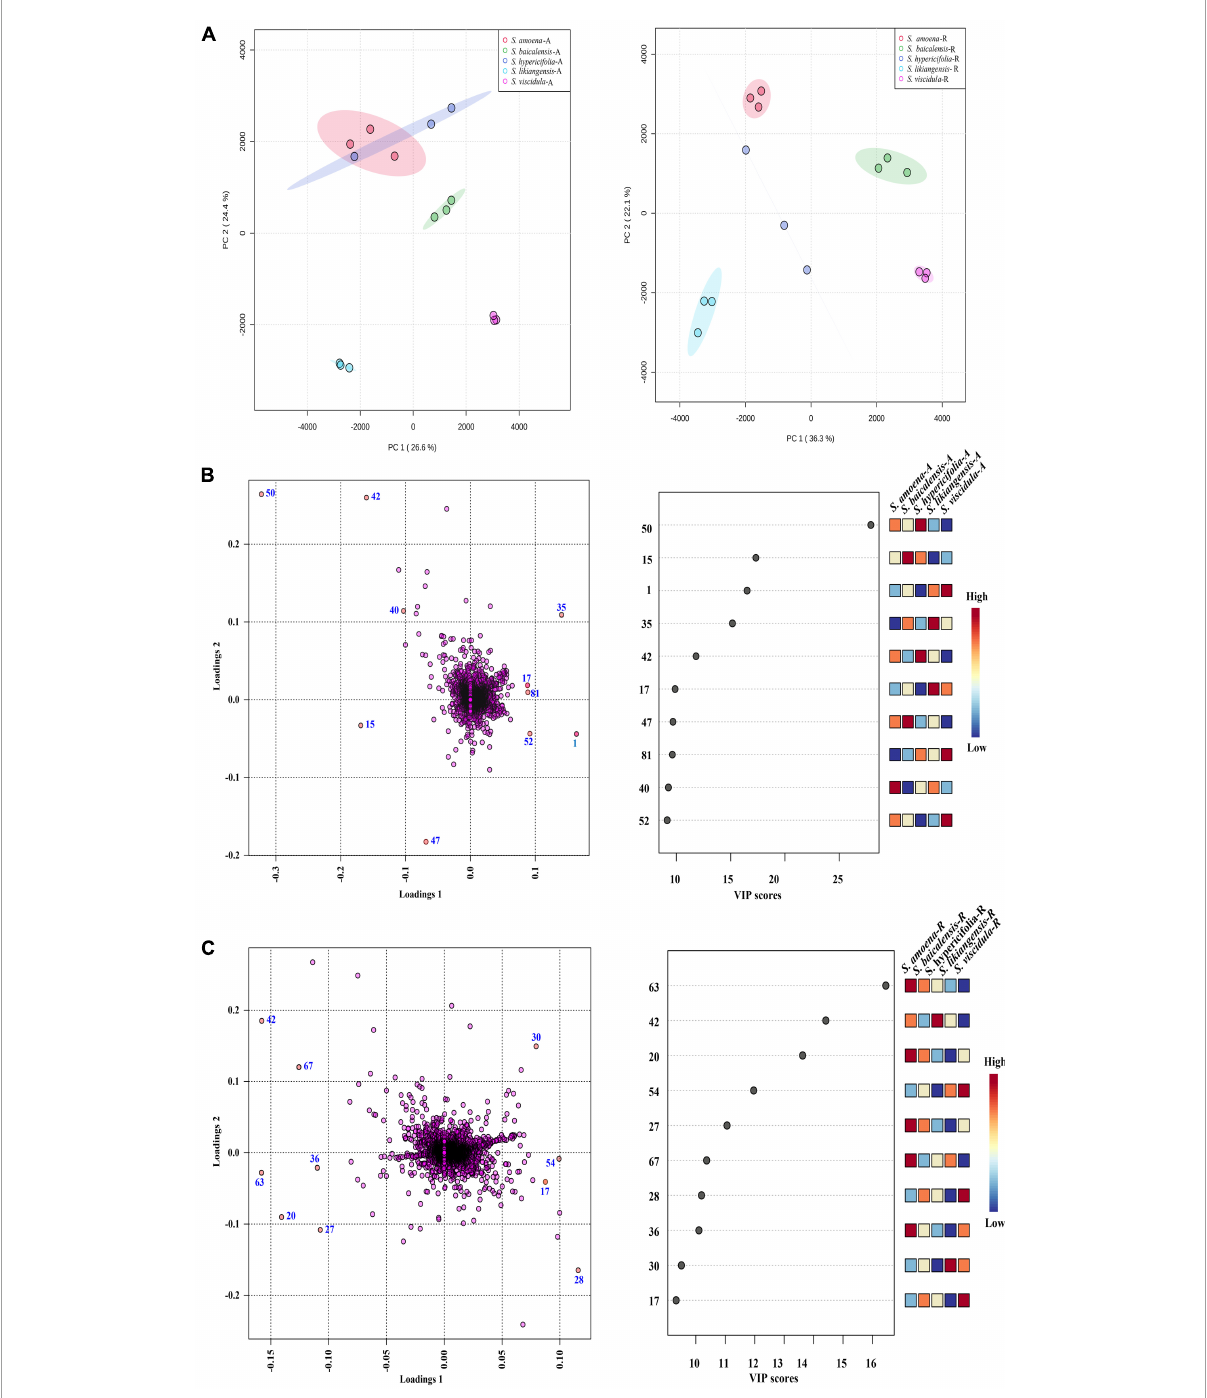
FIGURE3 The multivariate analysis of the metabolite data was derived from five Scutellaria species. (A) PCA score map of the different parts of Scutellaria species (-A: aerial parts, -R: roots). (B) The loading plot and variable importance in the projection of the PLS-DA model for the aerial parts of Scutellaria species. (C) The loading plot and variable importance in the projection of the PLS-DA model for the roots of Scutellaria species. (The colored boxes on the right indicate the relative concentrations of the corresponding metabolite in each group under study; the number of the metabolites corresponds to Table 1